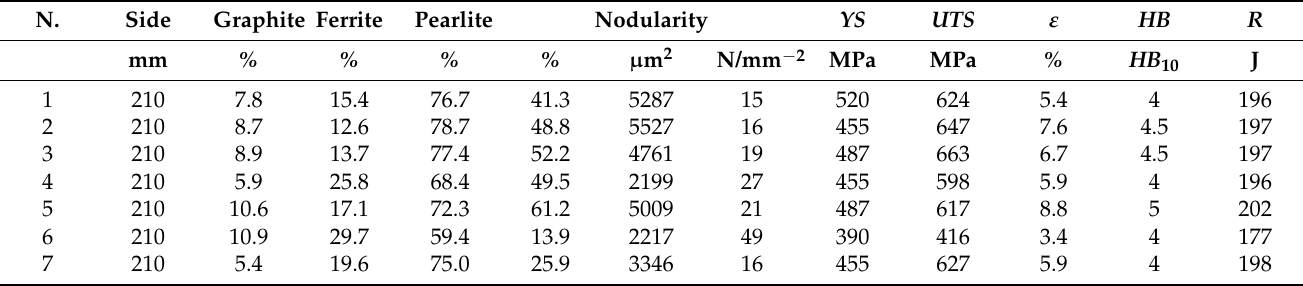
Table A1. Metallographic characteristics (graphite, ferrite and pearlite contents; nodularity; density; and area of graphite nodules) and mechanical properties of the spheroidal cast iron (yield strength ( YS ), tensile strength ( UTS ), elongation at break [ ε ], hardness ( HB ) and resilience ( R